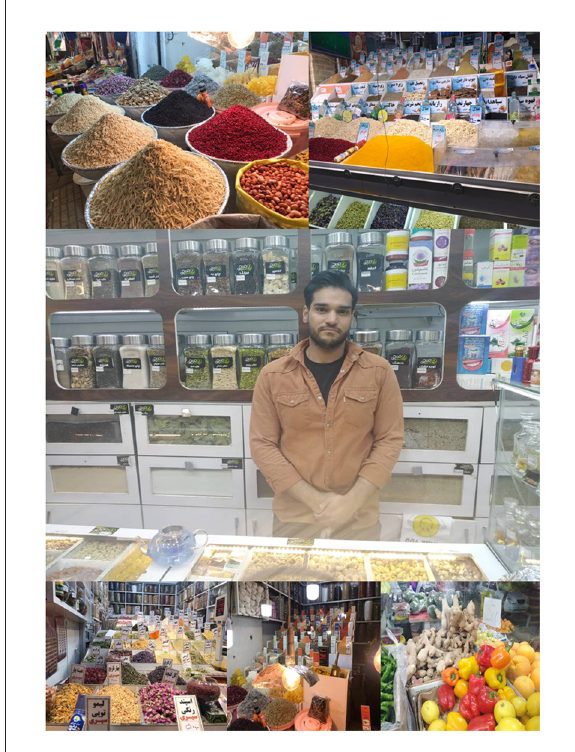
FIGURE8 Local herbal and spices markets in Iran. Consumers should carefully check the flavor and taste of purchased spices and herbal products to reduce the health risks of AFs. The color of AF-contaminated spices, in some cases, changed significantly, and characterization of contaminations and spoiled materials is easy. In the case of invisible AFs contaminants, preparing regular samples from local herbal and spice markets will decrease the occurrence of these carcinogenic